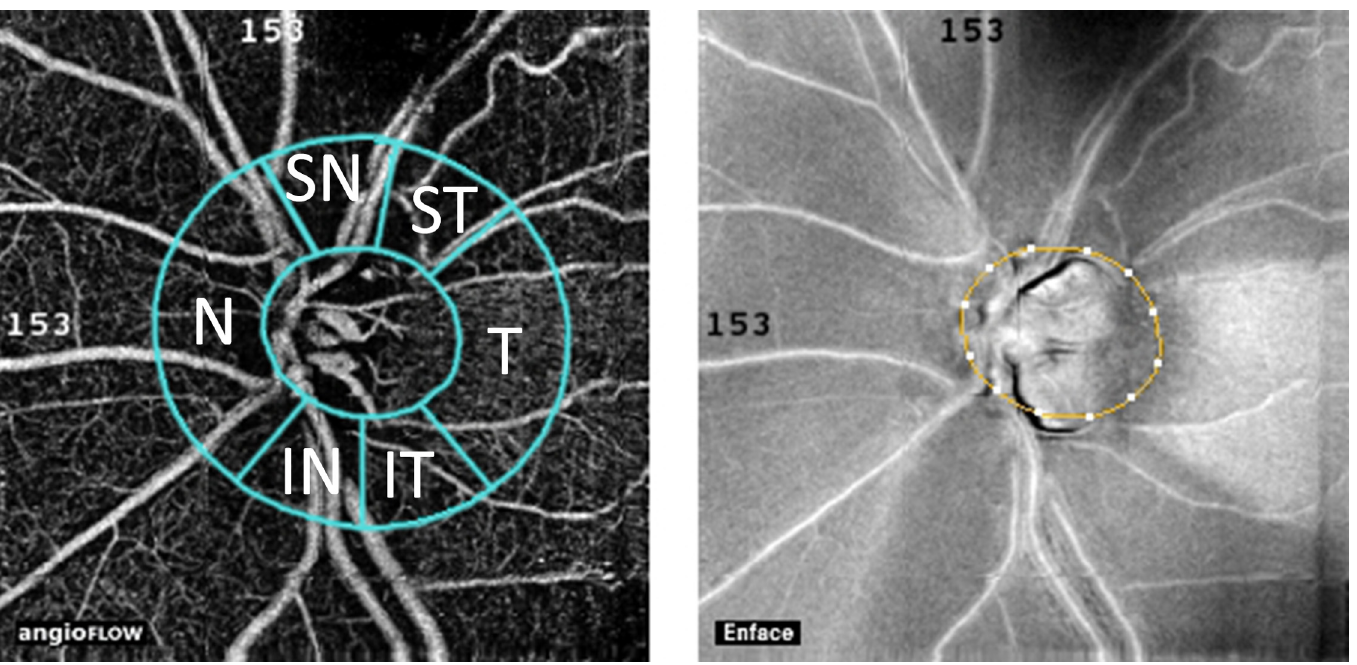
Fig 1. Positions of the peripapillary sectors given by the Optovue 2015.100.0.33 software version for peripapillary vessel density measurement with the Angiovue OCT.